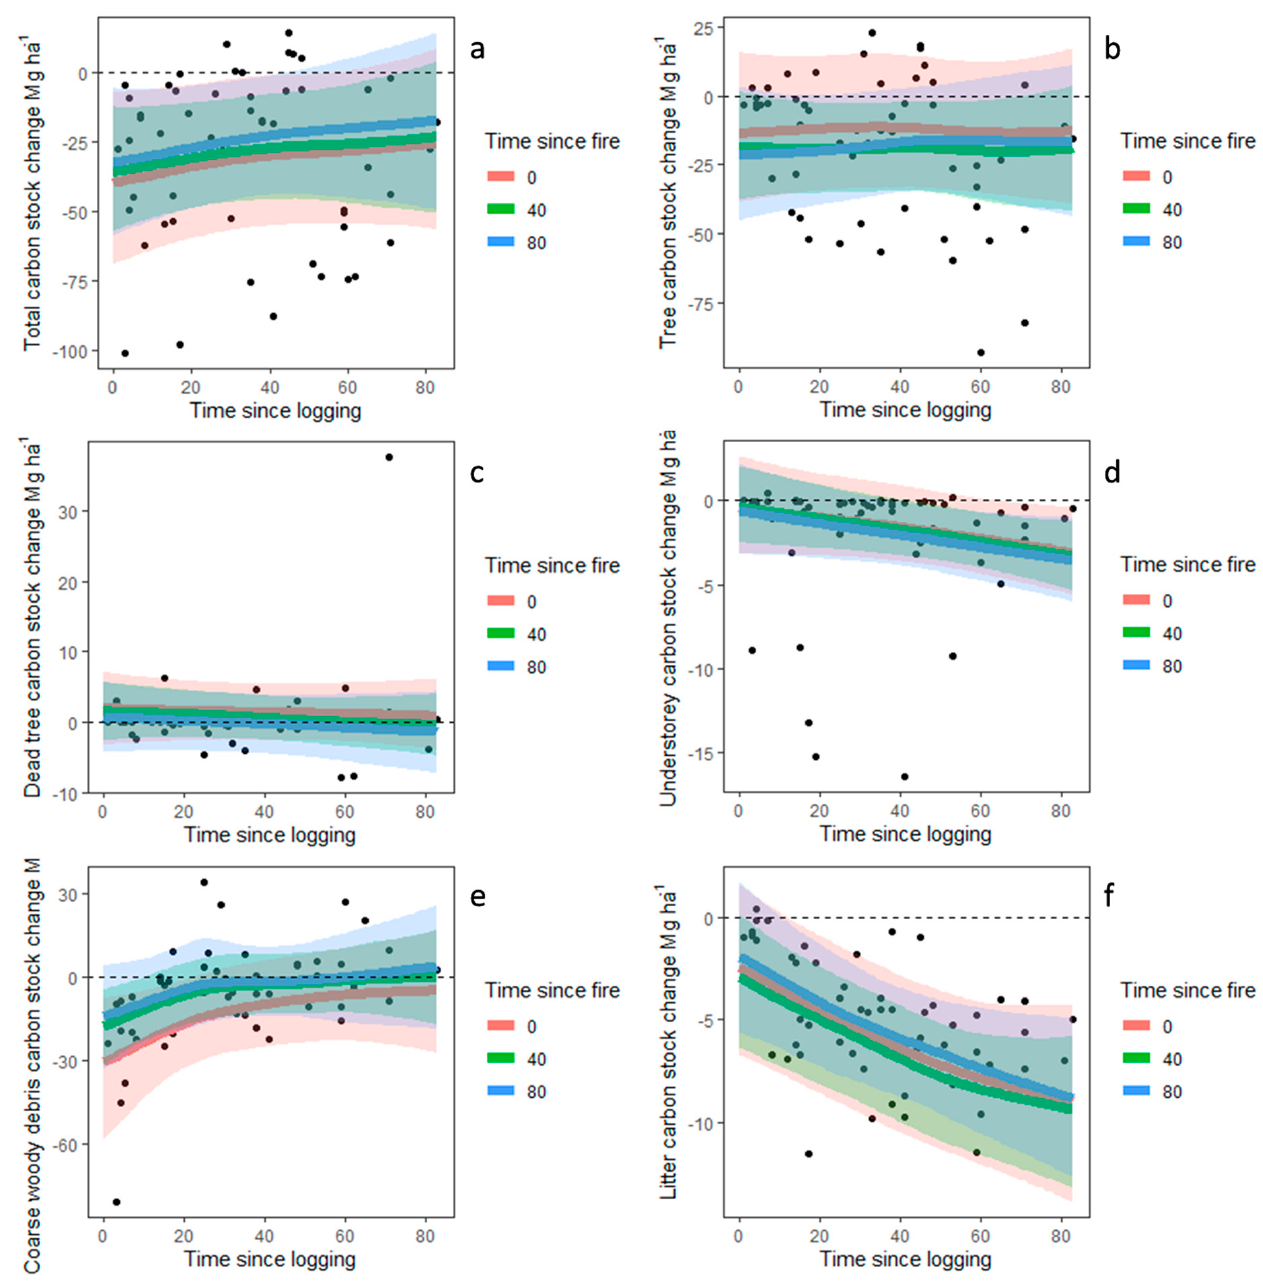
Figure 4. Change in above ground carbon stocks between the pre- and post-fire carbon surveys plotted against time since logging and time since the previous wildfire for total ( a ), live tree ( b ), dead tree ( c ), understorey ( d ), coarse woody debris ( e ) and litter ( f ) carbon stocks. in each of the carbon pools. Solid lines and transparent ribbons indicate the median and 90% posterior density intervals respectively fitted by three levels of time since wildfire with observed values (black dots). Predictions were made with fire severity fixed at ‘high’, topographic position at ‘Slope’, time since hazard reduction at 10–35 years and all other variables at their mean.